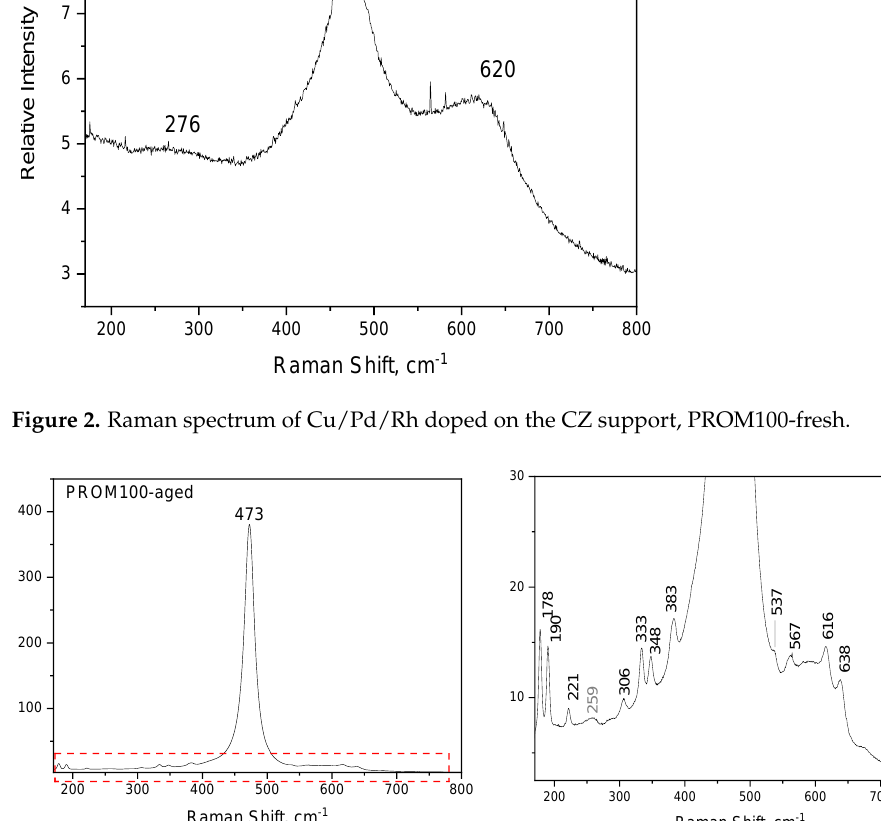
Figure 3. ( a ) Raman spectrum of PROM100-aged; ( b ) focus on the low-intensity bands observed.